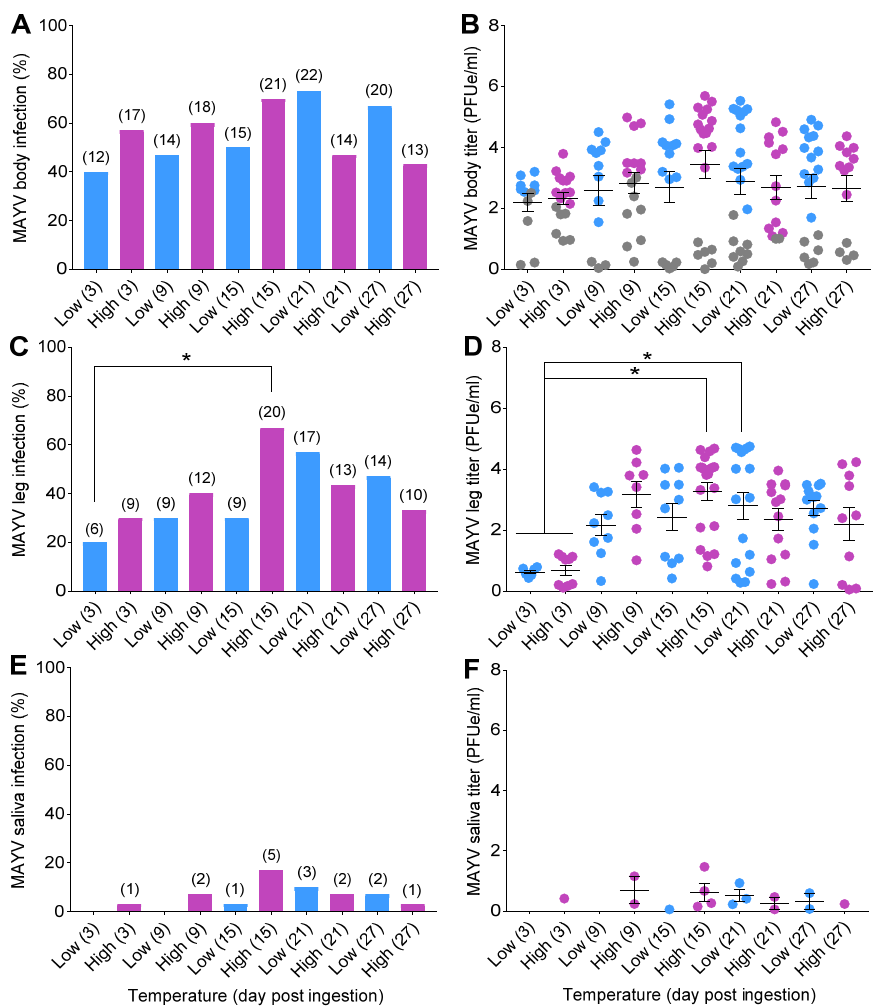
Figure 3. Temperature influences on mosquito competence for MAYV. Mosquitoes were challenged with ingestion of MAYV-infected bloodmeal (7 log 10 PFUe/mL) for 1 h at 28 ◦ C; then, engorged females were placed in separate environmental incubators (20 ◦ C = low; 30 ◦ C = high) for the remainder of the study. At 3, 9, 15, 21, and 27 dpi, mosquitoes ( n = 30/time point) were anesthetized with CO 2 , and their wings and legs were removed from their bodies, followed by a collection of salivary secretions. ( A ) MAYV susceptibility to infection (body), ( C ) disseminated infection (legs), and ( E ) transmission (salivary secretions) expressed in percentages. The kinetics of MAYV growth in mosquito tissues and salivary secretions were determined by qRT-PCR. ( B ) MAYV titer of body, ( D ) legs, and ( F ) salivary secretions, represented as (PFUe/mL). Each data point in ( B , D , F ) represents the kinetics of MAYV growth (titer) of individual mosquitoes. Gray data points in ( B ) represent mosquitoes with non-disseminated infection (i.e., MAYV infection limited to the midgut). Numbers in brackets above bars indicate the total number of mosquitoes positive for MAYV. Horizontal lines indicate the mean ± SEM. Statistical significance was determined using logistic regression analysis and two-way ANOVA for MAYV infection measurements and titers, respectively. p -values were corrected for multiple comparisons. Asterisks (*) denote significant differences; p < 0.05. MAYV titers in mosquito bodies ( F = 0.96; df = 9,20; p = 0.49) or salivary secretions ( F = 0.83; df = 9,20; p = 0.59) (Table 2). However, we detected a highly significant effect of time on MAYV titers in legs of mosquitoes ( F = 4.49; df = 9,20; p = 0.002) (Table 2). The titers in mosquito bodies and legs tended to be higher 3, 9, and 15 dpi at 30 °C than at 20 °C (Figure 3B,D).